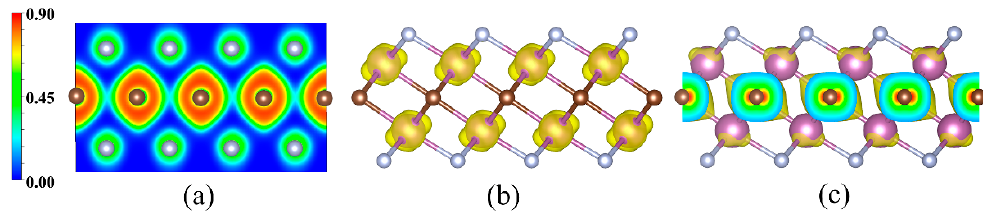
Figure 8. ( a ) The ELF contour plot perpendicular to the (100) direction for 2D Sc 2 CF 2 . The band decomposed charge density of the ( b ) CBM and ( c ) VBM for 2D Sc 2 CF 2 .